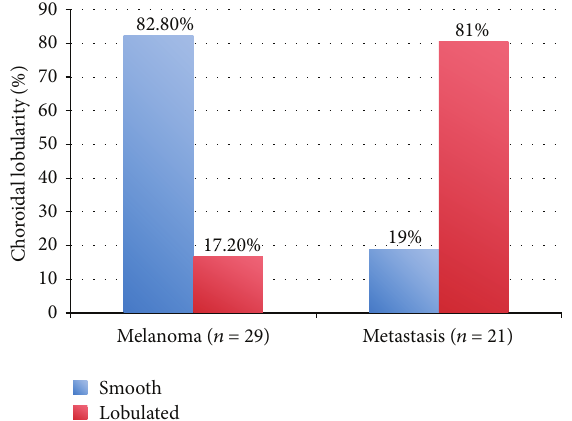
Figure 6: Choroidal lobularity. More than 80% of the choroidal metastases had a lobulated choroidal surface, whereas only 17% of the malignant choroidal melanomas were